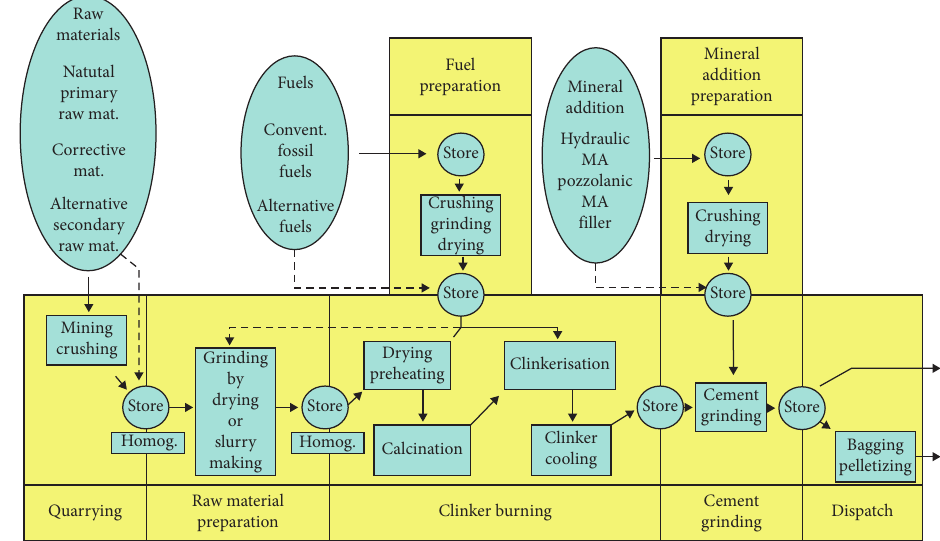
Figure 1: Simplified cement production process [10].